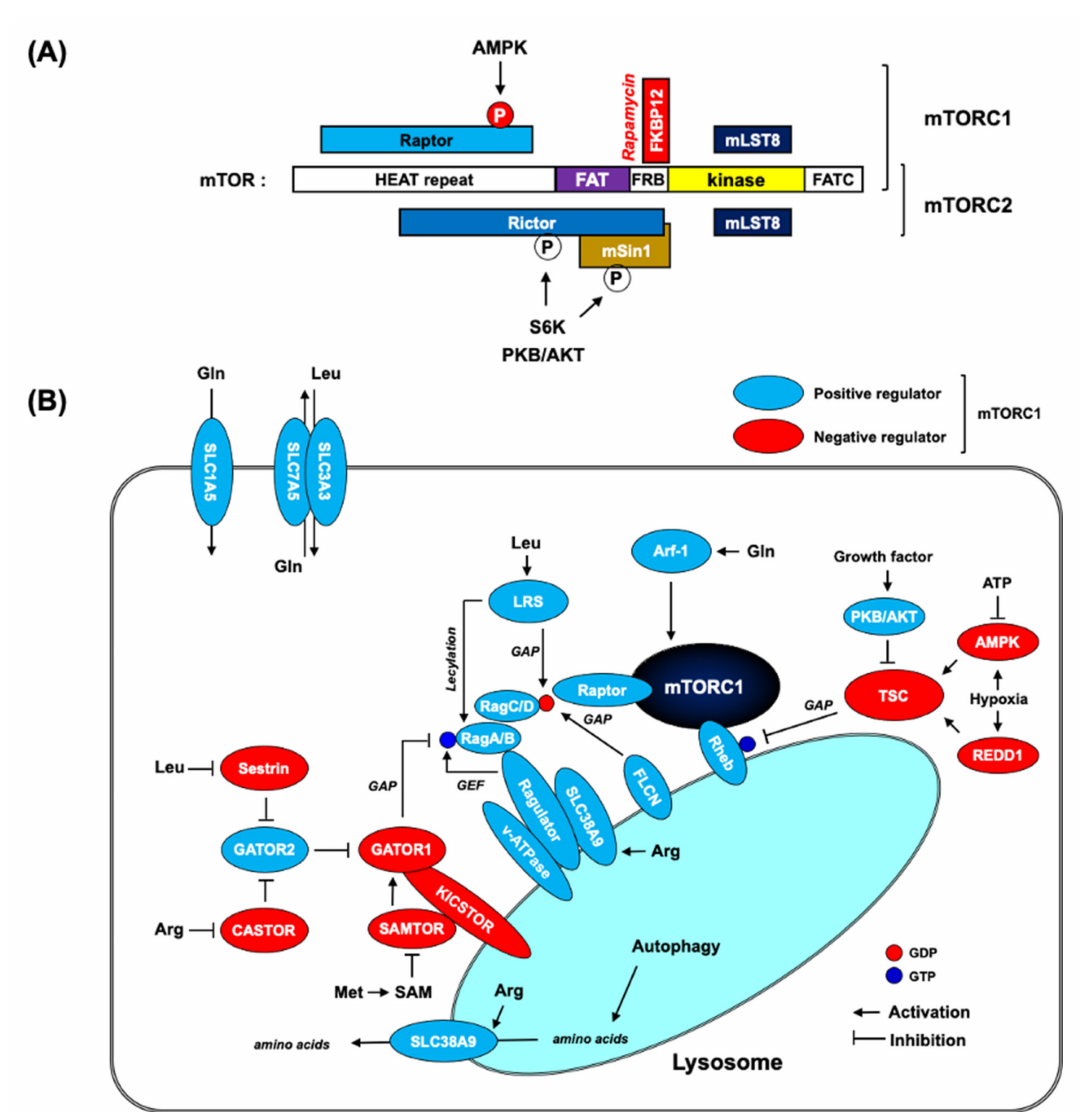
Figure 2. mTORC and its nutrient signaling modules. ( A ) A schematic representation of mTOR domain structure and mTORC subunits. mTOR is composed of a huntingtin-elongation factor 3-regulatory subunit A of PP2A-TOR1 (HEAT) repeat, a FRAP-ATM-TRRAP (FAT) domain, a FKBP12-rapamycin binding (FRB) domain, a catalytic domain (kinase), and a FAT domain at the C terminus (FATC). mTORC1 includes mTOR, regulatory-associated protein of mammalian target of rapamycin (Raptor), and mammalian lethal with sec-13 protein 8 (mLST8). Raptor is a phosphorylation target of AMPK, which leads to mTORC1 inactivation upon AMPK activation. mTORC2 contains mTOR, rapamycin-insensitive companion of mTOR (Rictor), mammalian stress-activated MAP kinase-interacting protein 1 (mSin1), and mLST8. The binding of Rictor and mSin1 masks the FRB domain on mTOR to prevent FKBP12–rapamycin binding, thereby rendering mTORC2 insensitive to rapamycin. mTORC2 is shown to be phosphorylated by PKB/AKT, as well as a downstream kinase S6K in mTORC1 signaling, but it is debated whether their physiological significance entails activation or inhibition. ( B ) mTORC1 and amino acid signaling network. mTORC1 is activated by Rheb on lysosomes. Therefore, localization of mTORC1 is required for activation, which is dependent on the intracellular amino acid level. Rag GTPase is a major arm for transmitting information on intracellular amino acid into mTORC1. In an amino acid-rich condition, the active Rag GTPase (GTP-loaded RagA/B and GDP-loaded RagC/D) binds to Raptor to recruit mTORC1 onto lysosomes. Many different amino acid-sensing molecules directly or indirectly regulate GTP/GDP loading status on Rag GTPase complex. Additionally, Rheb is negatively regulated by the TSC complex, a GAP for Rheb. The TSC complex integrates many different inputs (growth factors, cellular energy level, and oxygen level) to fine-tune Rheb for the tight regulation of mTORC1 signaling in response to various extracellular and intracellular cues. The proteins shown in the figure are not drawn to